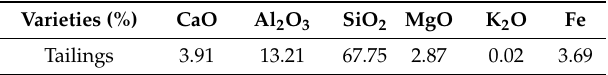
Table 1. The chemical components of tailings.